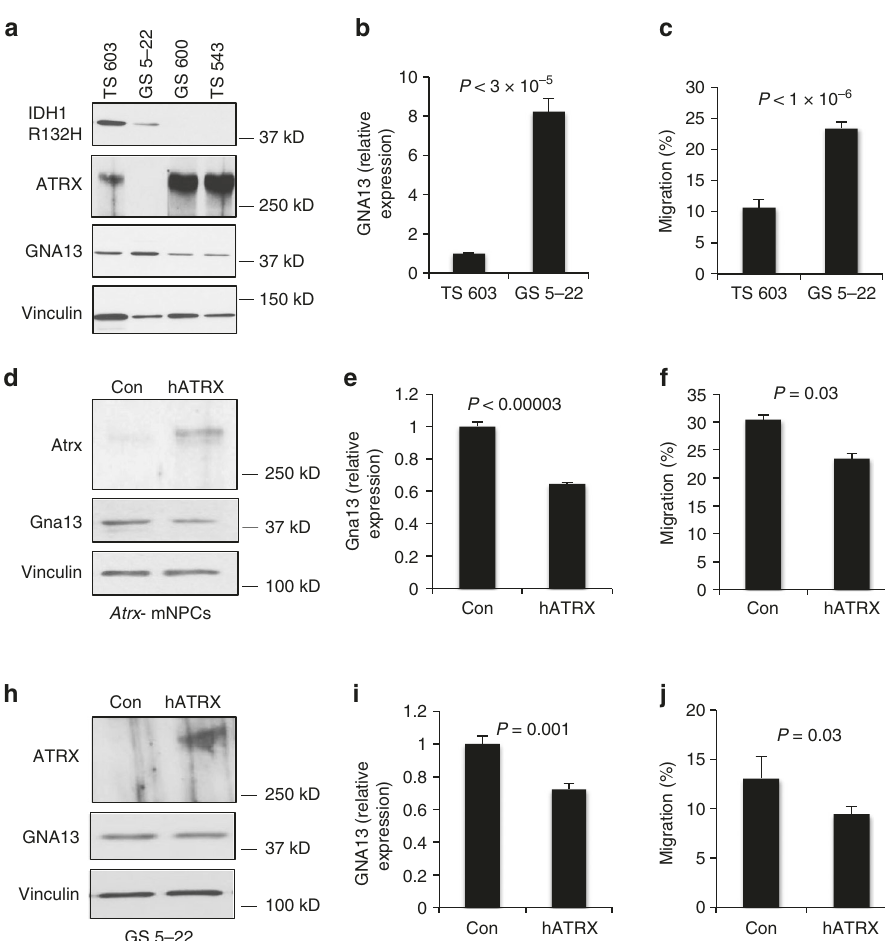
Fig. 7 GNA13 promotes cell migration in ATRX -mutant GSCs. a , b western blot ( a ) and RT-qPCR ( b; three replicates) showing increased GNA13 expression in IDH1 -mutant (IDH1 R132H), ATRX-de fi cient GSC line (GS 5 – 22). c transwell migration assay (5 replicates) demonstrating increased motility in IDH1 - mutant, ATRX-de fi cient GSC line (GS 5-22) relative to IDH1 -mutant, ATRX-intact GSC line (TS 603). d – e western blot ( d ) and RT-qPCR ( e ; three replicates) showing decreased Gna13 expression upon transient transfection of Atrx- mNPCs with human ATRX (hATRX) relative to control vector (Con). f transwell migration assay (5 replicates) demonstrating decreased motility in hATRX transfected, Atrx - mNPCs. h – i western blot ( h ) and RT-qPCR ( i; three replicates) showing decreased GNA13 expression upon transient transfection of GS 5-22 cells with hATRX relative to Con. j transwell migration assay (5 replicates) demonstrating decreased motility in hATRX transfected GS 5-22 cells. All western blots used Vinculin as a loading control. In all cases, error bars re fl ect standard deviation and P values determined by unpaired two-tailed t